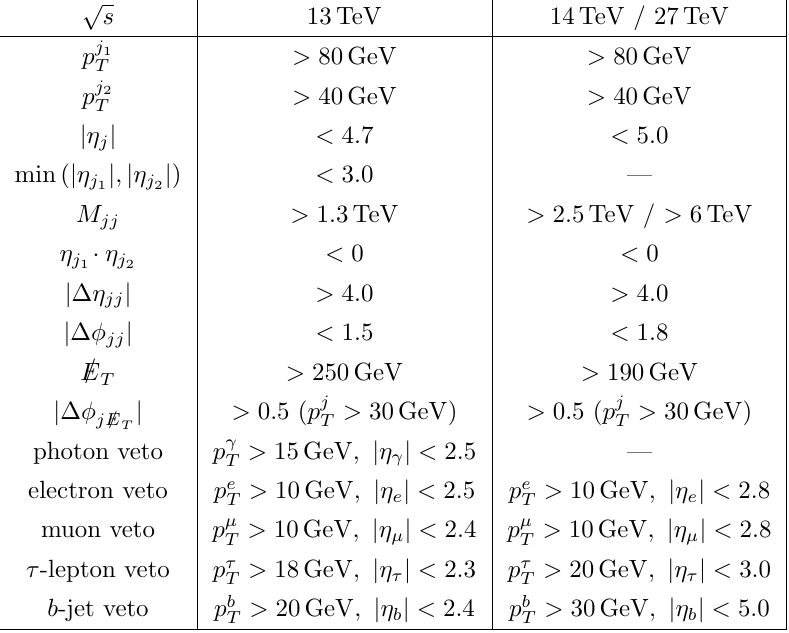
Table 1 . Analysis cuts used in this paper. The cuts for 13 TeV and 14 TeV are taken from [39] and [42], respectively. The cuts for the 27 TeV HE-LHC are identical to the ones for the 14 TeV HL-LHC except for the cut on M jj